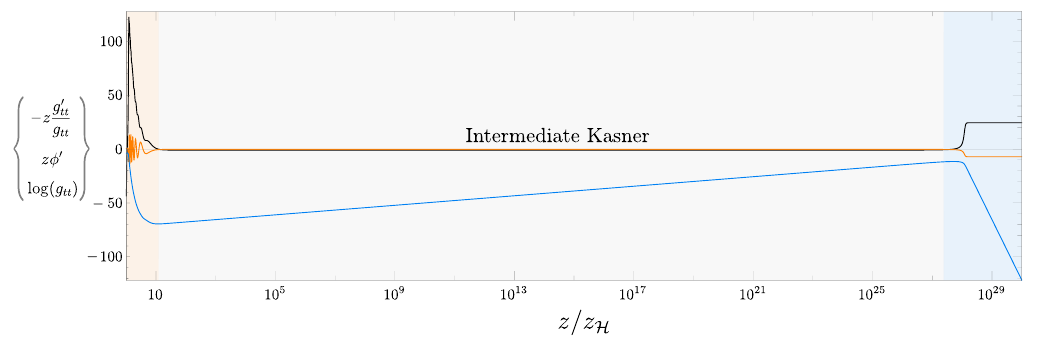
Figure 1: Journey through the inside of a holographic superconductor. At a value of / g z close to the inner horizon of AdS RN, zg (cid:48) (black) experiences a large kick at tt tt which g (blue) becomes very small. We call this the collapse of the Einstein-Rosen tt bridge. Immediately afterwards, the scalar field φ (orange) goes through a series of / g Josephson oscillations, imprinting a series of short steps on zg (cid:48) . This all occurs tt tt at relatively small z / z (orange shaded region, shown also in Fig. 2). The oscilla- H tions settle down to an intermediate Kasner regime with exponent p int . This Kasner t epoch lasts for an exponentially long range of z / z (but short proper time) before H < 0) after which the interior has a final receiving yet another kick (whenever p int t = − p int / ( 2 p int + 1 ) > 0 (blue shaded region). The scalar Kasner exponent with p t t t = field derivative inverts: z φ (cid:48) → 2 / ( z φ (cid:48) ) . Here q = 1, m 2 = − 2 and T / T c